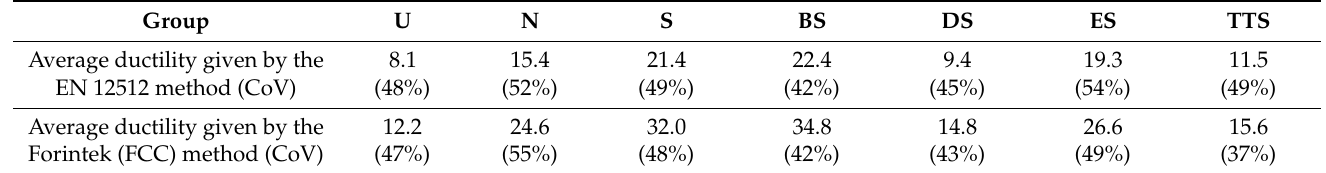
Table 5. Average ductility of each group calculated using two methods [31].